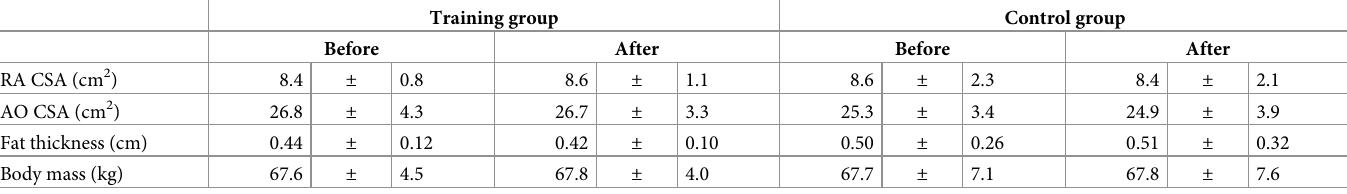
Table 1. Abdominal muscle cross-sectional area, fat thickness, and body mass before and after the intervention